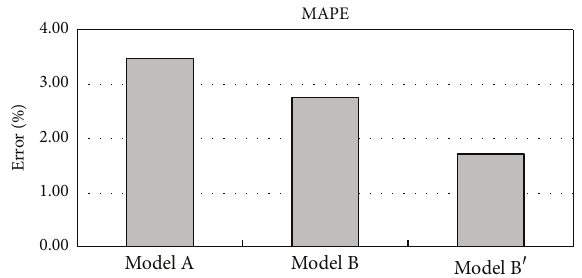
Figure 5: MAPE of Model A, Model B, and Model B 󸀠